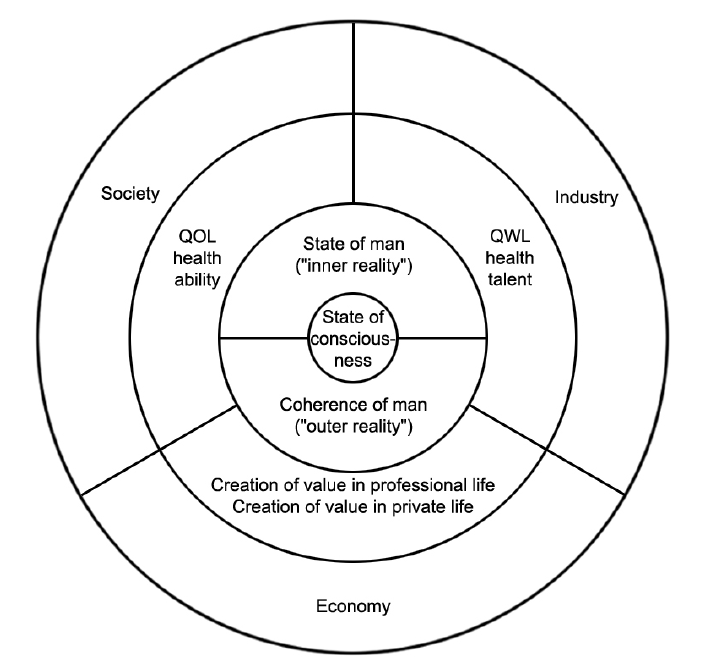
FIGURE 2 . If you want to make basic science likely to give a major scientific breakthrough that will improve society, industry, and economy in the future, you are most likely to succeed if you find a key-point-project, a research project that focuses on how to understand and how to develop an important and causal aspect of the world; the state of consciousness seems to be such a key